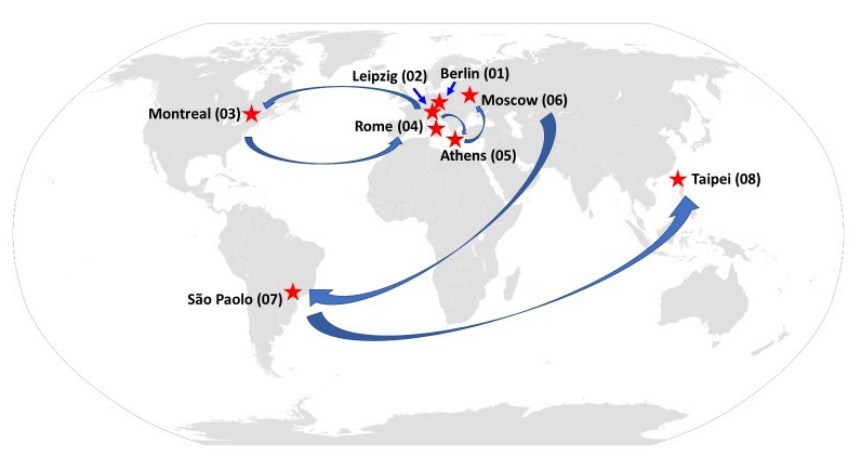
Fig. 1 Map of issue locations with issue numbers of Flaneur , 2013–19. Location and movement design by Natasha Anderson (2020). Data from ‘Shop Magazine’, Flaneur Magazine (2019) [accessed 4 November 2019]; map outline from Wikimedia Commons